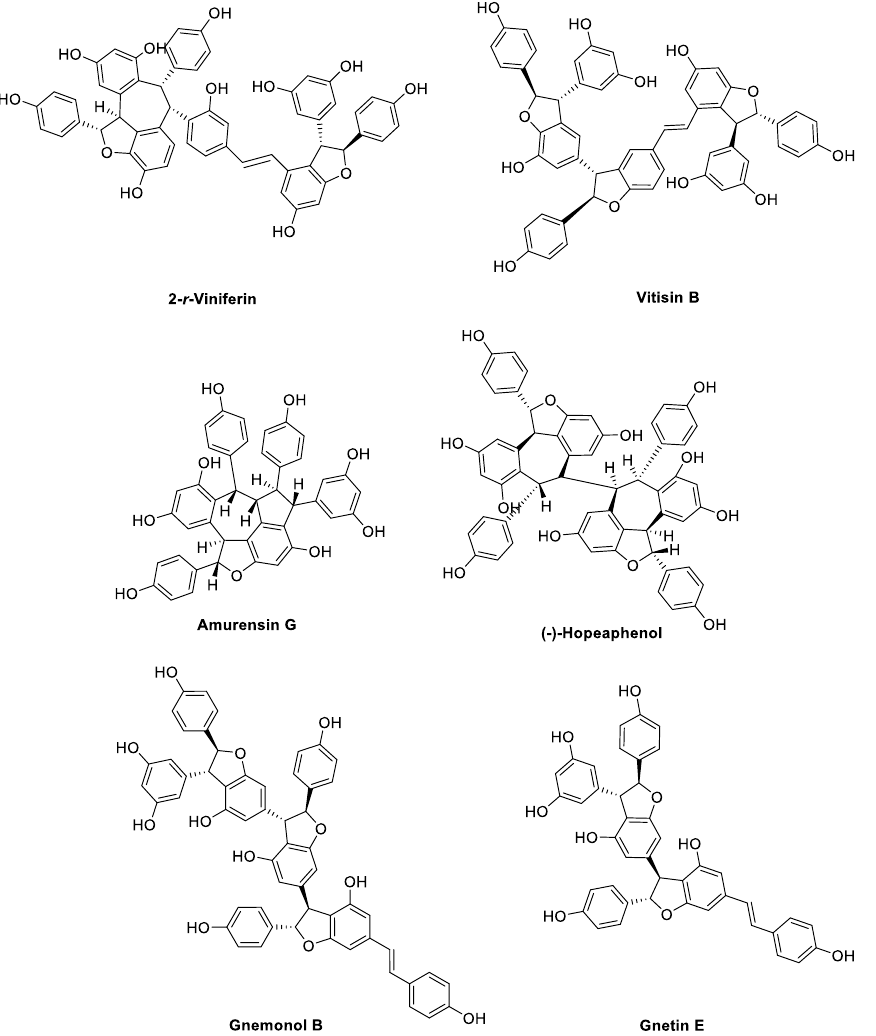
Figure 18. Structures of oligomeric stilbenoids from Shen et al. (2009) [32], Keylor et al. (2015) [100], and Sáez et al. (2018) [101].